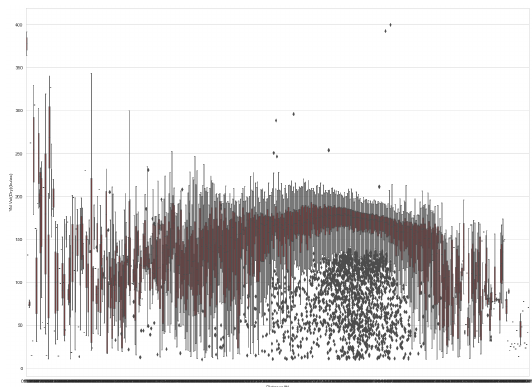
Figure 3. Box plot for Distance (ft) vs. Yld Vol